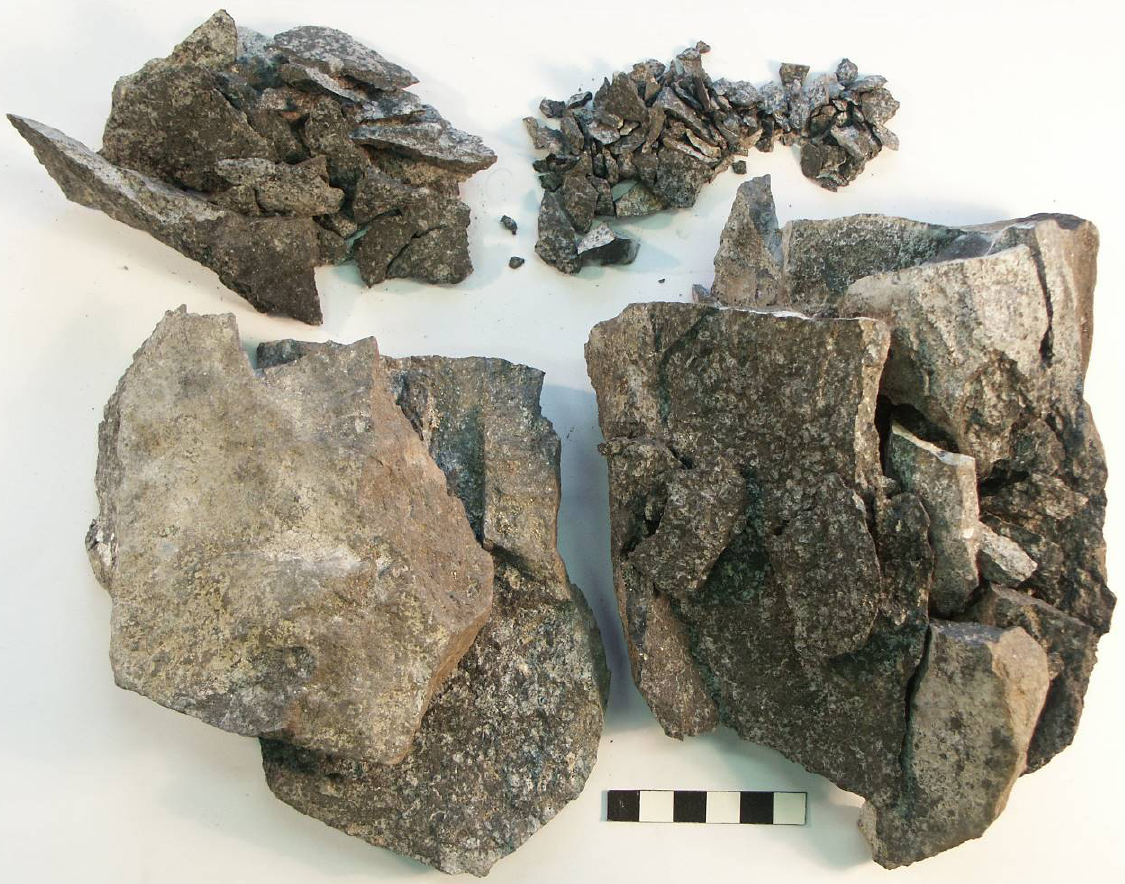
Figure 20. Fragments of experimental heat shattered basalt. Note the flat thin specimens. Scale in